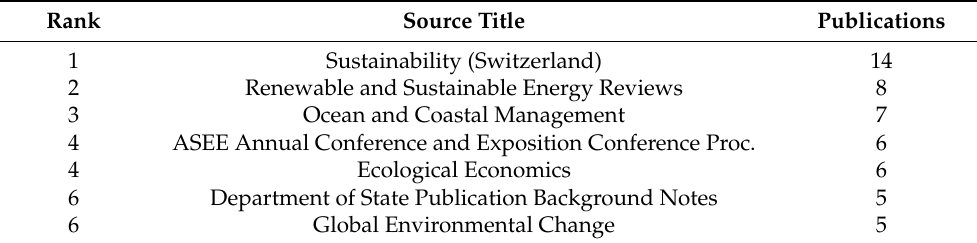
Table 5. Top seven source